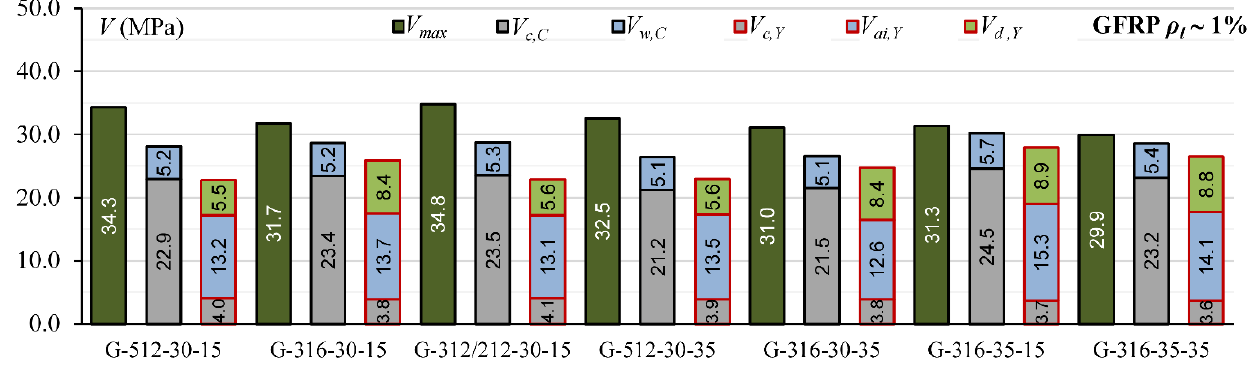
Figure 9. The comparison of shear mechanism contribution for steel-reinforced beams with rein- forcement ratio ρ l ~ 1% for Cladera et al.’s and Yang’s models. Figure 10. The comparison of shear mechanism contribution for GFRP and steel RC beams with reinforcement ratio ρ l ~ 1.4% for Cladera et al.’s and Yang’s models.